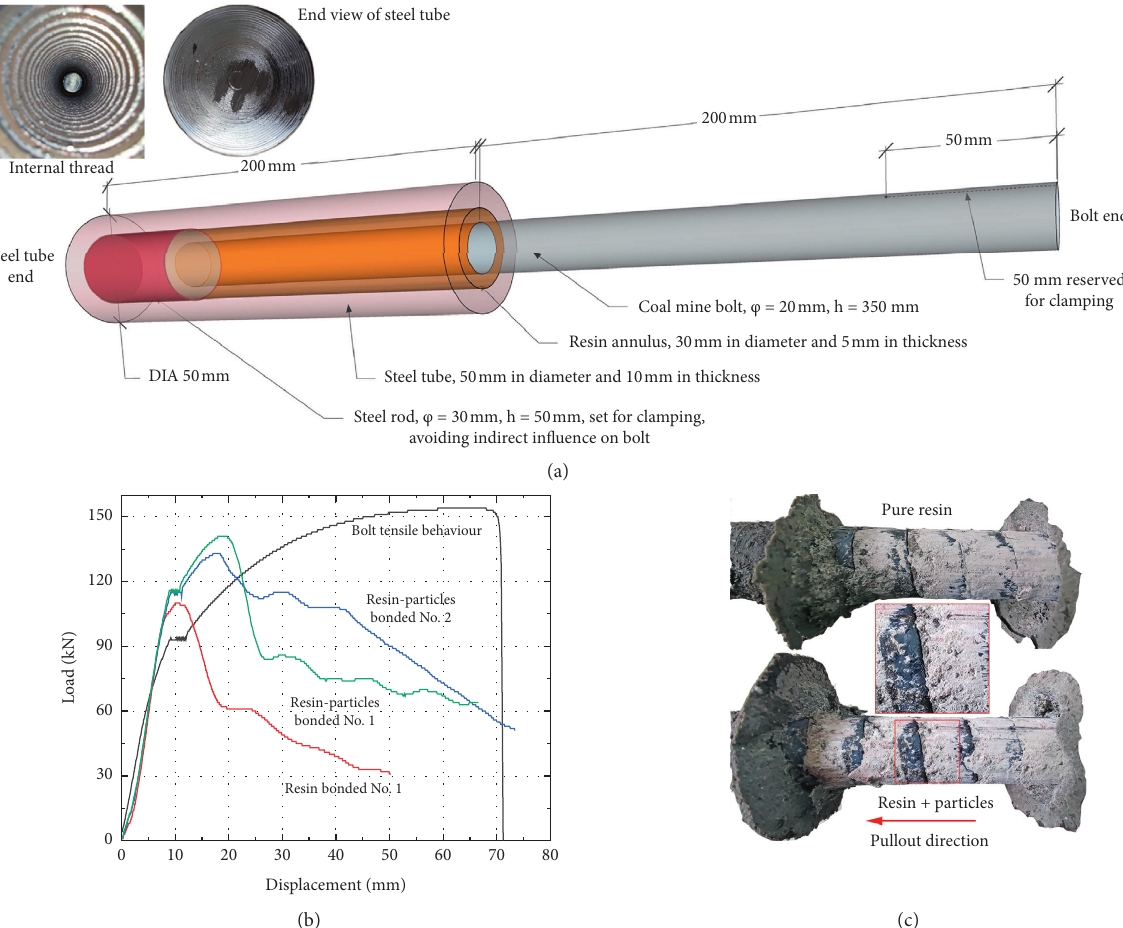
Figure 9: Experimental setup for pullout test and relevant results. (a) Schematic diagram of specimens for pullout test, (b) displacement vs. load for tested specimens, and (c) failure patterns for resin bonded specimen and resin-particles bonded